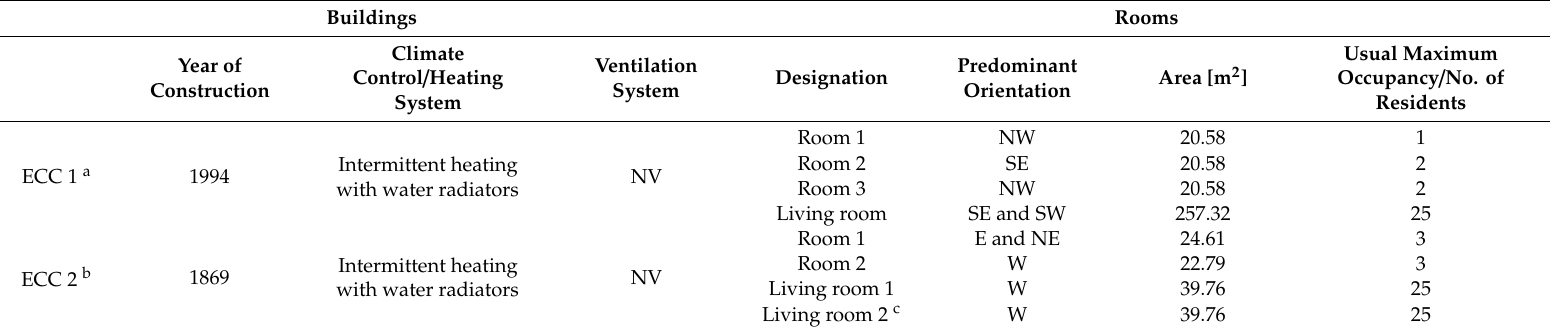
Table 1. Viseu: physical characterization of the buildings and some of the studied